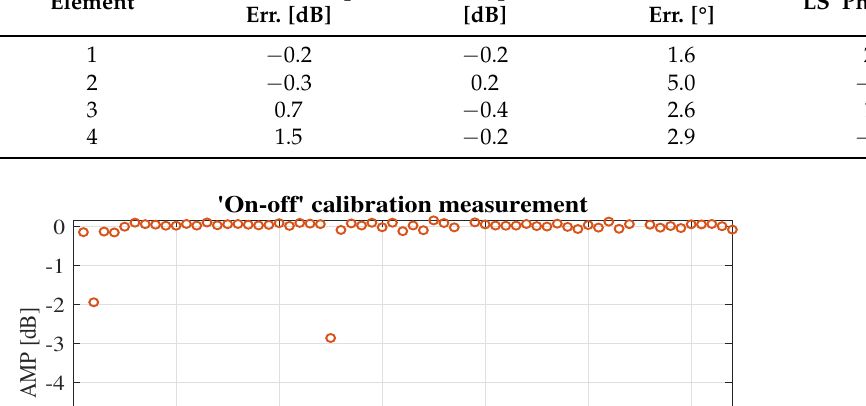
Table 1. Variation between the results of AiP elements calibration measurements. ‘On-off’ Amp. ‘LS’ Amp. Err. Element Err. [dB]